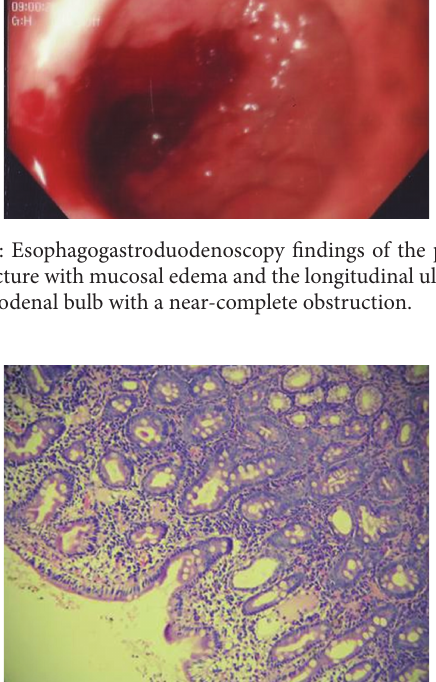
Figure 2: Foci of villous blunting, glandular destruction, mixed chronic inflammatory infiltrate in lamina propria, and cryptitis (H&Ex200).